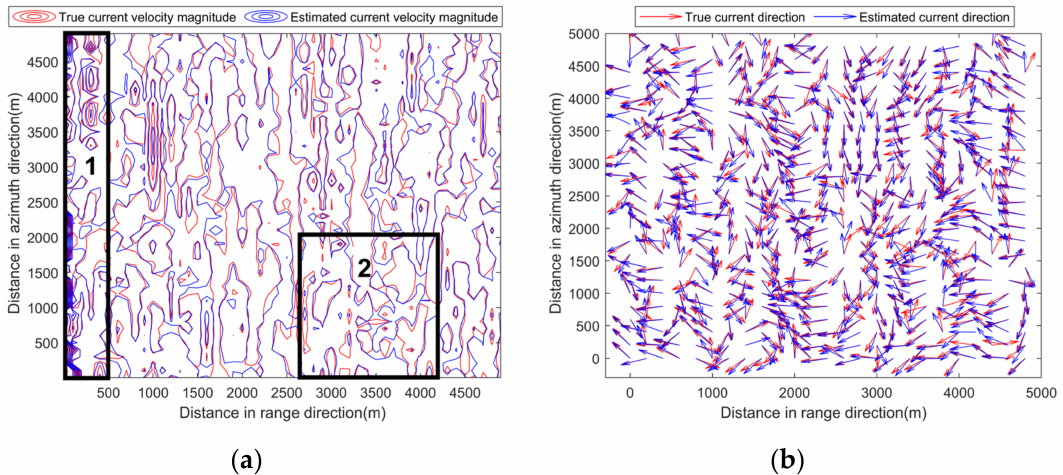
Figure 10. Comparison of measured currents and inversion results. ( a ) Current velocity magnitude. ( b ) Current direction. Region 1 indicates an area with large current velocity magnitudes, while region 2 indicates an area with small current velocity